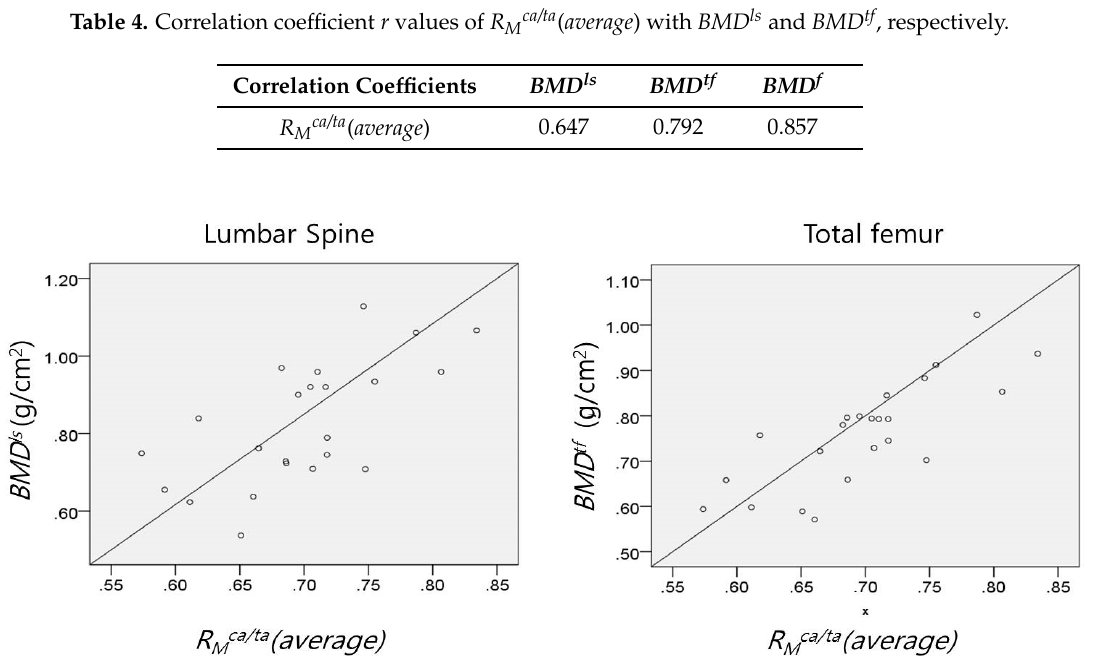
Table 4. Correlation coefficient r values of R Mca / ta ( average ) with BMD ls and BMD tf , respectively.